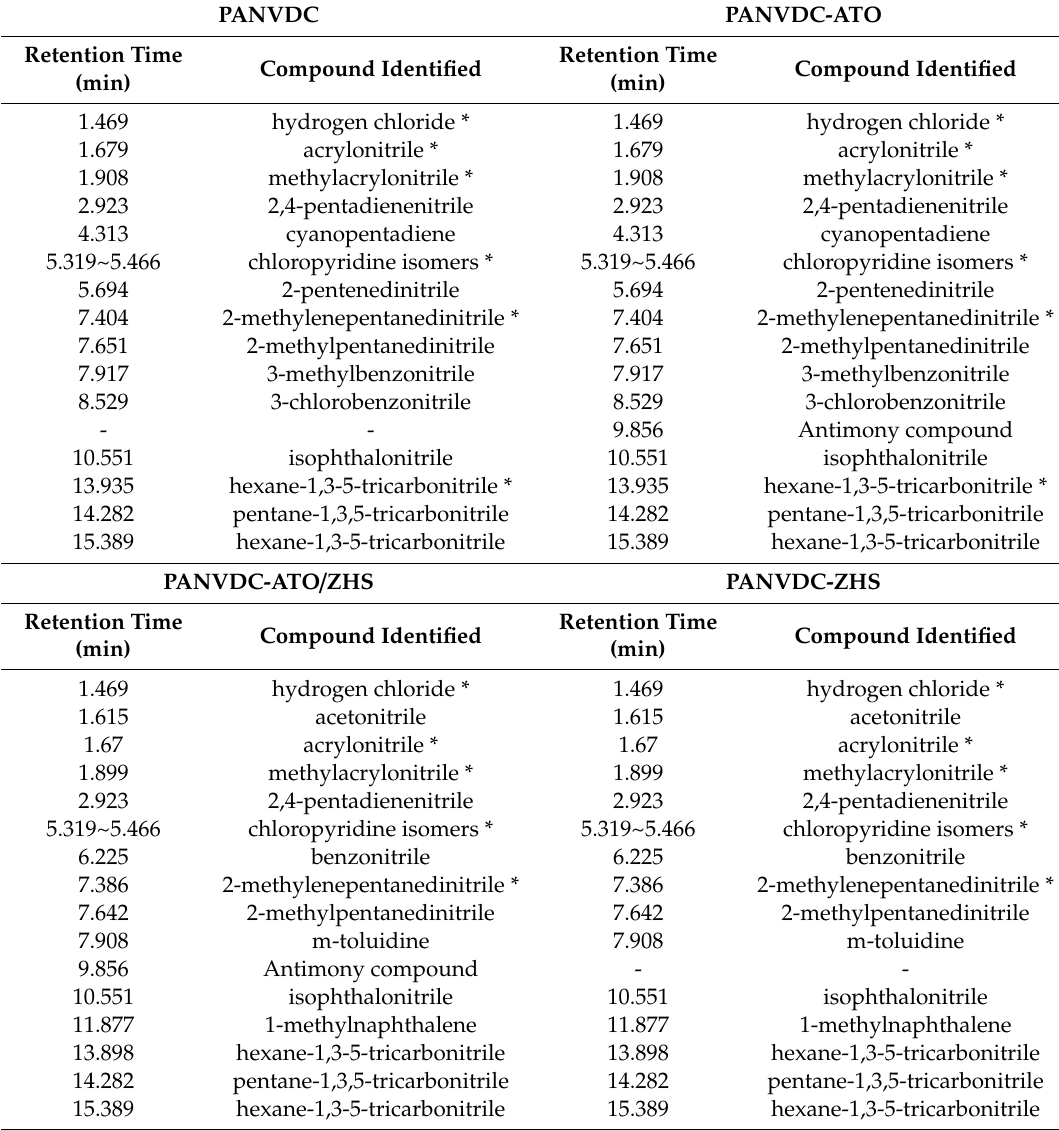
Table 3. Results of pyrolysis − gas chromatography-mass spectrometry (Py-GC / MS) of the PANVDC fibers with the flame